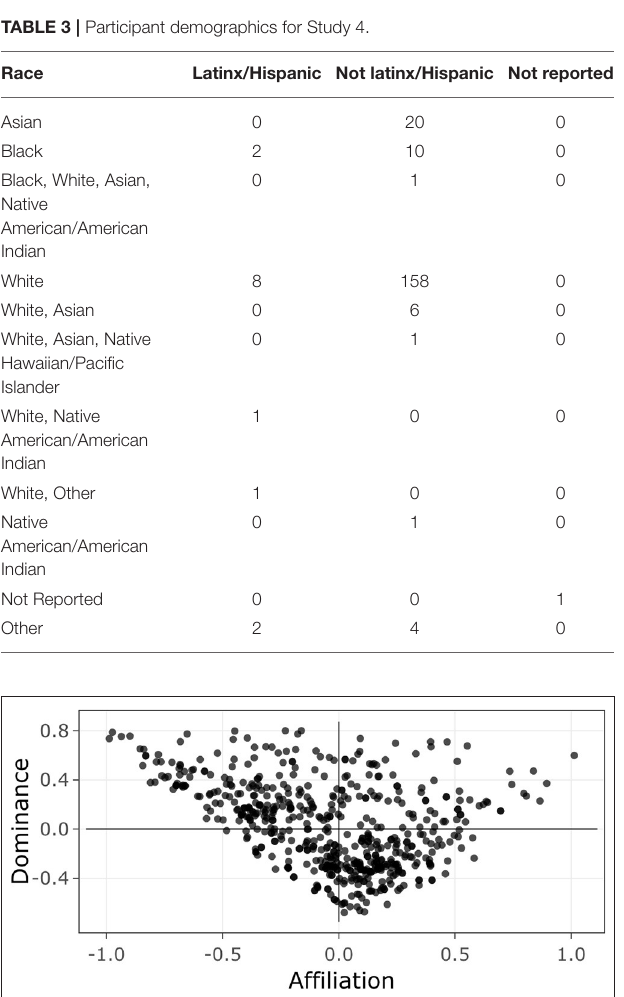
angle from the origin, θ , was calculated by first computing the radians from the arctangent function via θ = atan 2( y , x ) where x and y were each faces’ affiliation and dominance values, respectively, and then converted to degrees. Figure 4 shows the distribution of faces within each